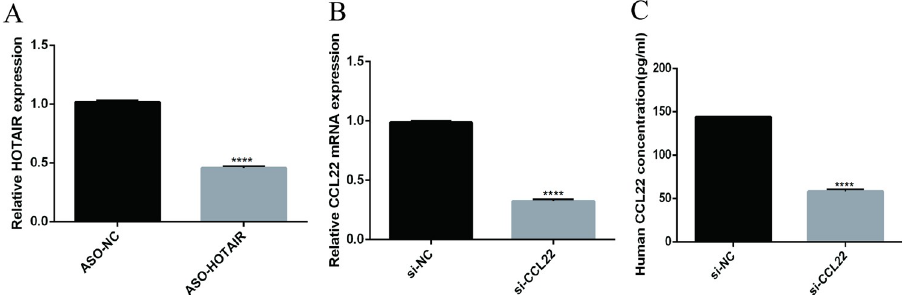
Fig 2. ASO-HOTAIR suppressing the HOTAIR expression and Si-CCL22 interferring the CCL22 expression. A, B: the expression of HOTAIR and CCL22 mRNA were detected by RT-qPCR. C: CCL22 protein analyzed by ELISA assay. ���� , P <